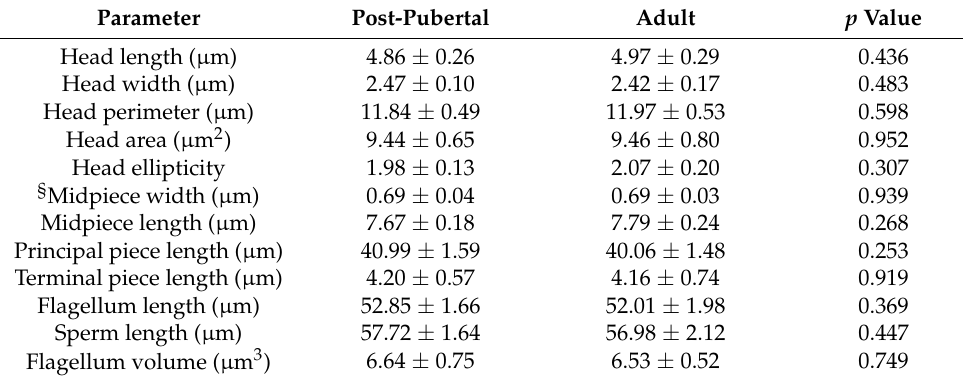
Table 5. Epididymal sperm morphometry in <1-year-old (post-pubertal, n = 9) and >1-year-old (adult, n = 7) sexually mature tomcats.